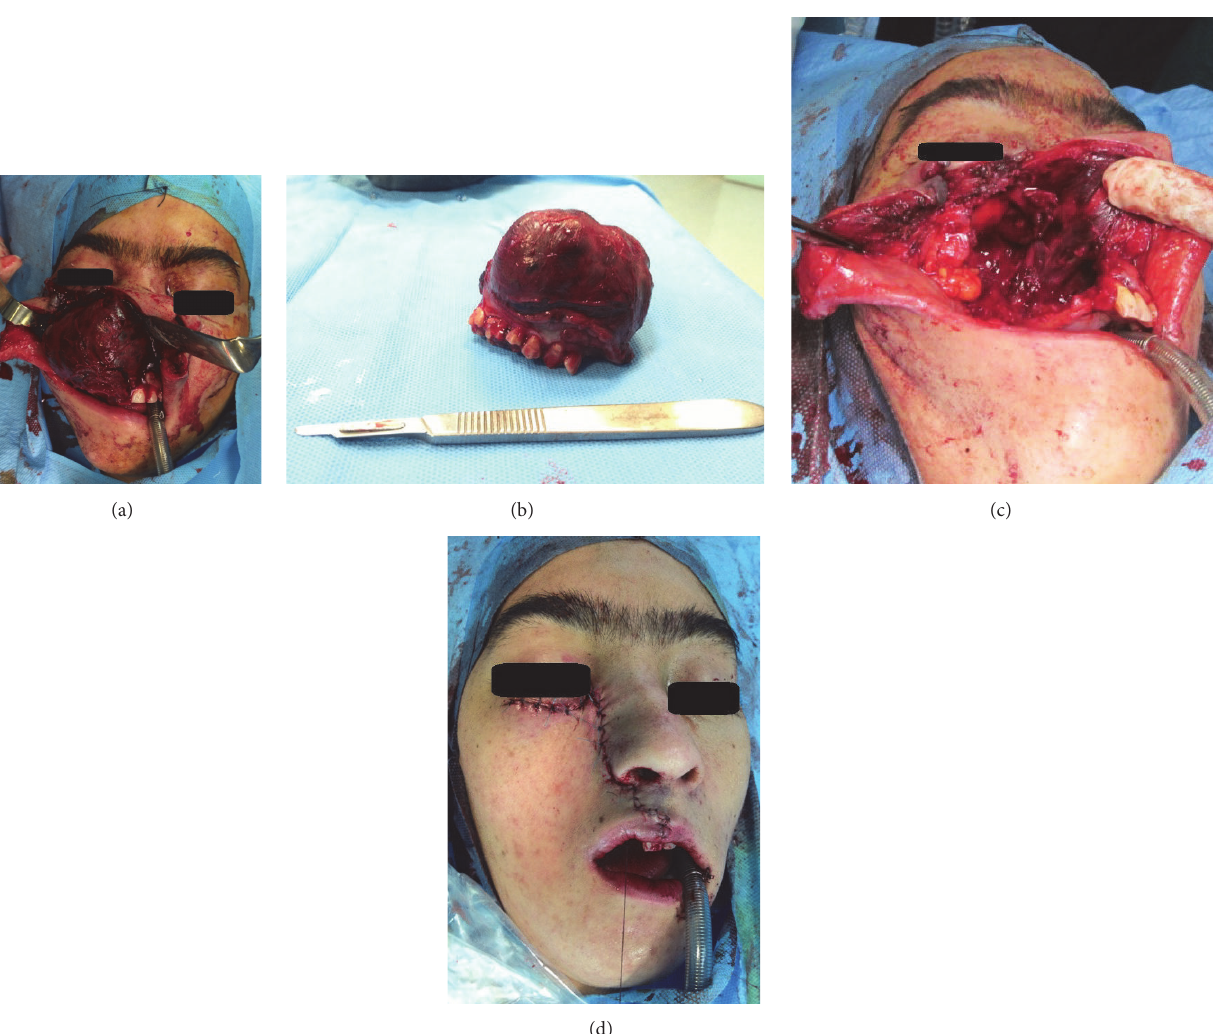
Figure 4: Intraoperative photograph shows the (a) macroscopic appearance of the lesion. (b, c) Resected specimen. (d)